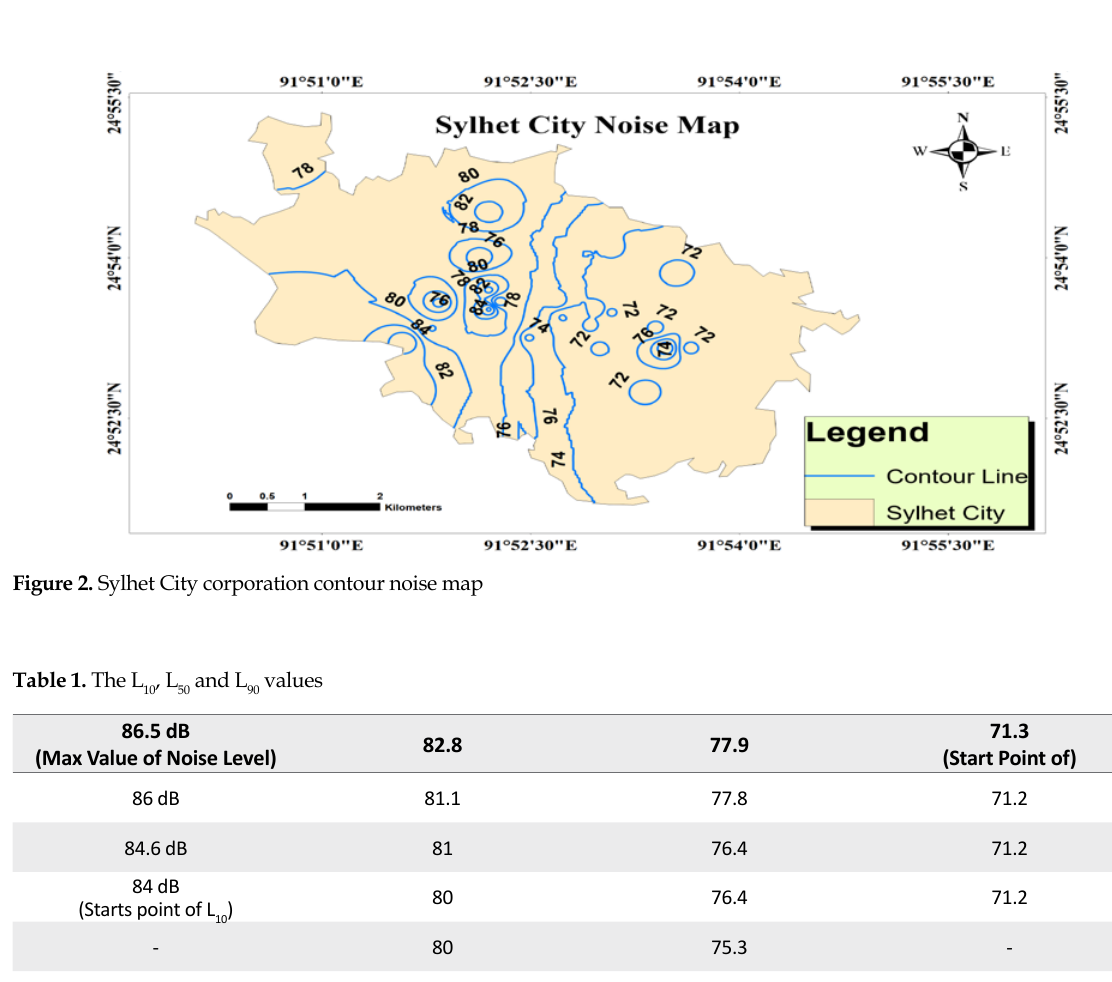
Figure 1. Sylhet City corporation